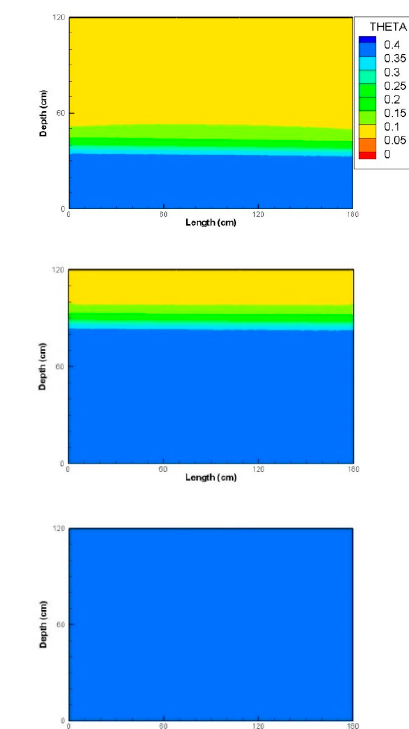
Figure 12. Results obtained for the second experiment including rainfall: presentation of the original photographs, maps resulting from image analysis method ( right side ) and numerical simulation ( middle ).